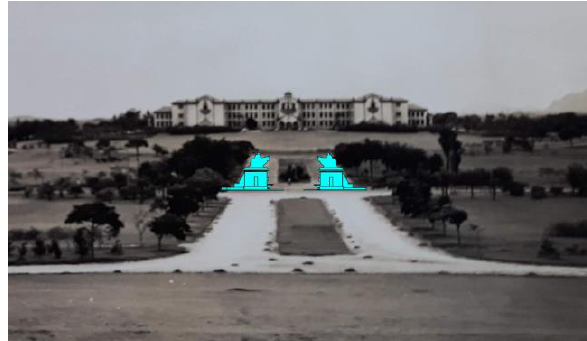
Figure 02 . Photomontage of the porch project. Elaborated by Scientific Initiation fellows Joanna Ribeiro; Beatriz Martins,